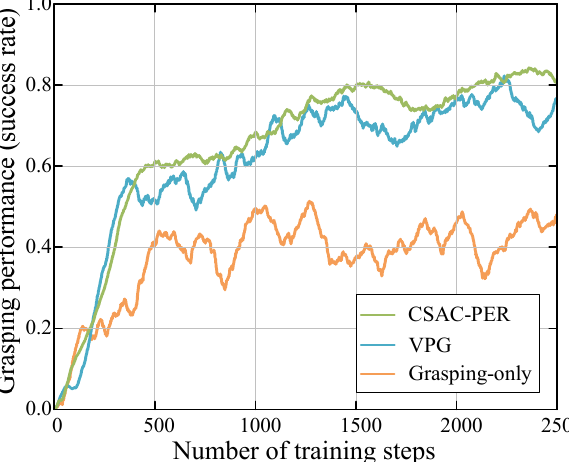
Figure 6. Grasping performance of different baselines methods.